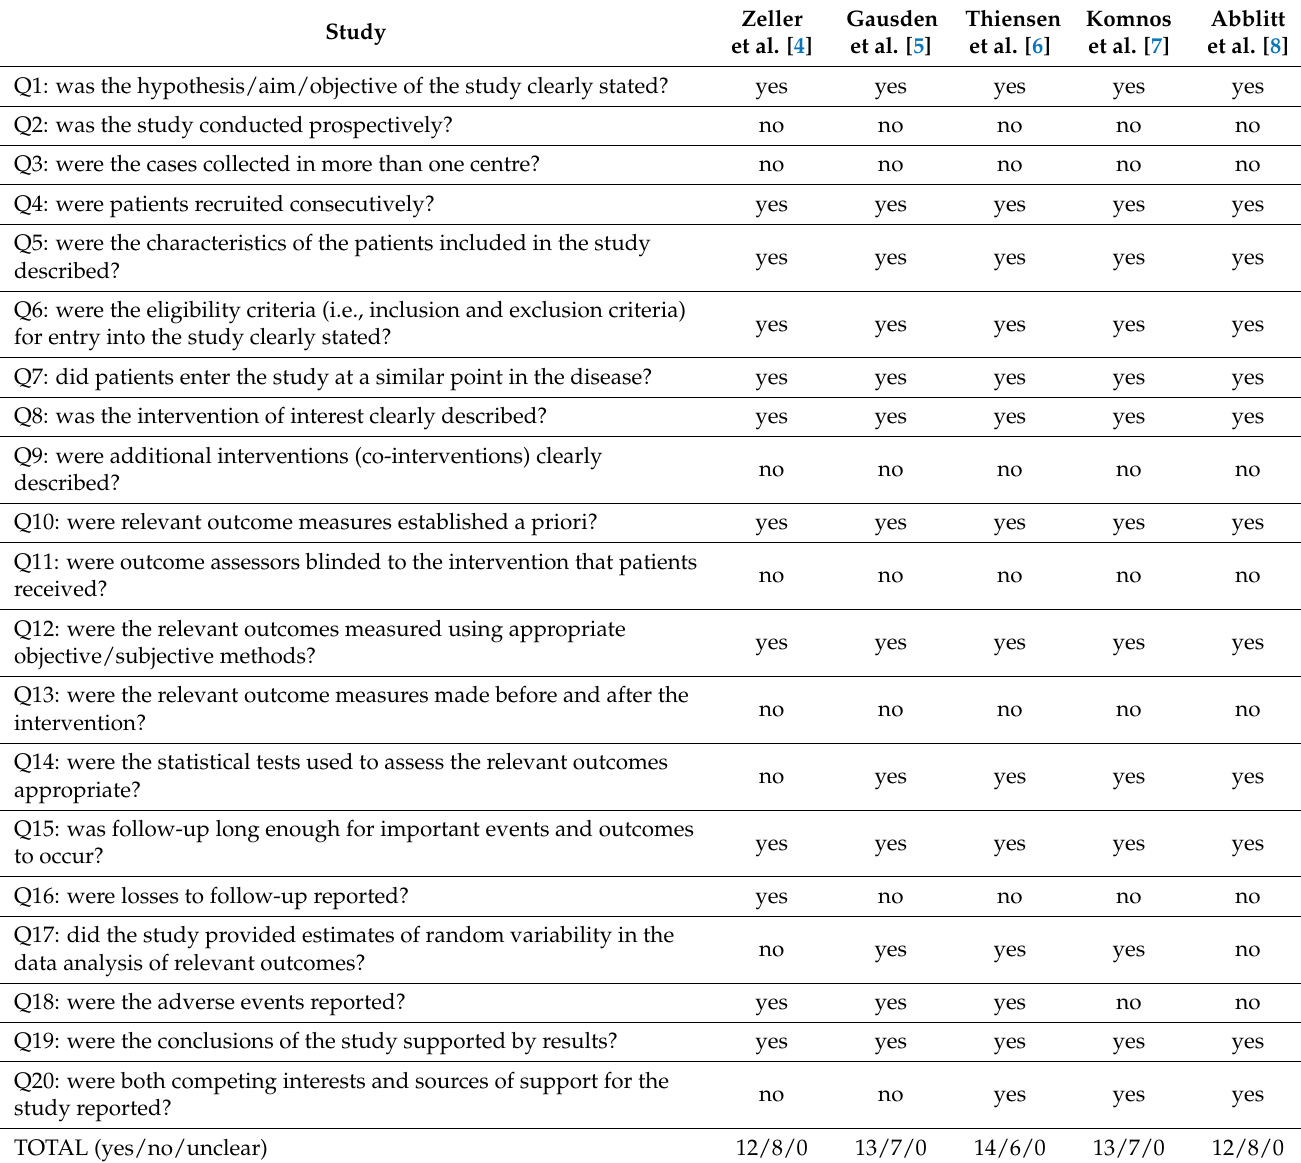
Table 1. IHE quality appraisal checklist for case series included in this review.